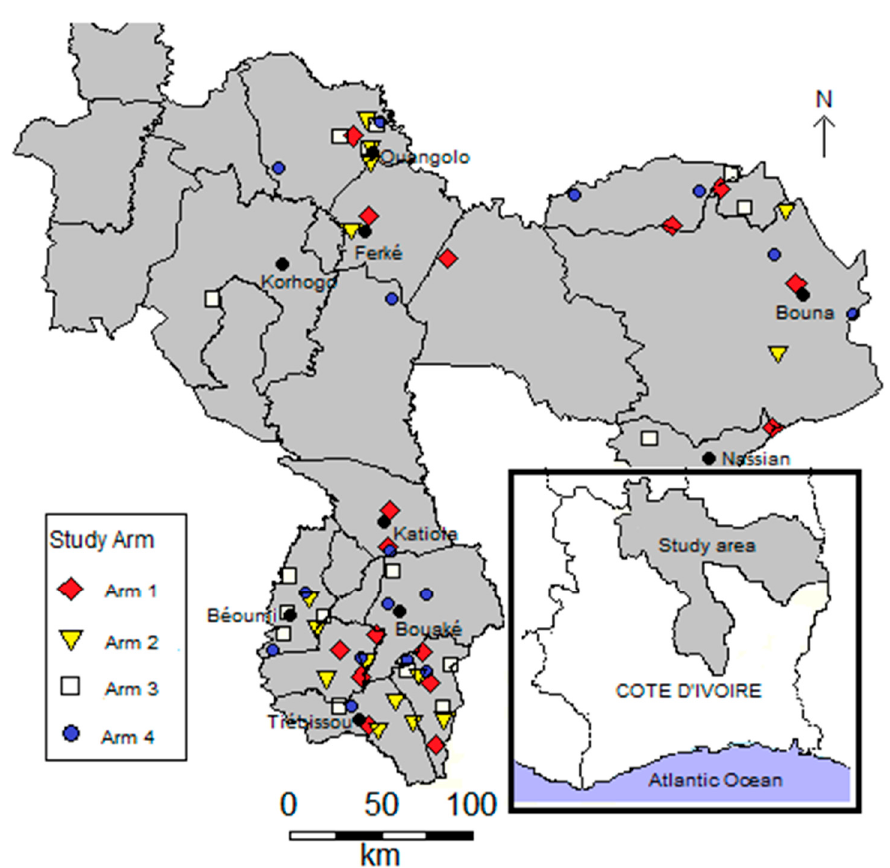
Figure 1. Map of the study area showing villages by arm in the northern and central parts of Côte d’Ivoire (n =